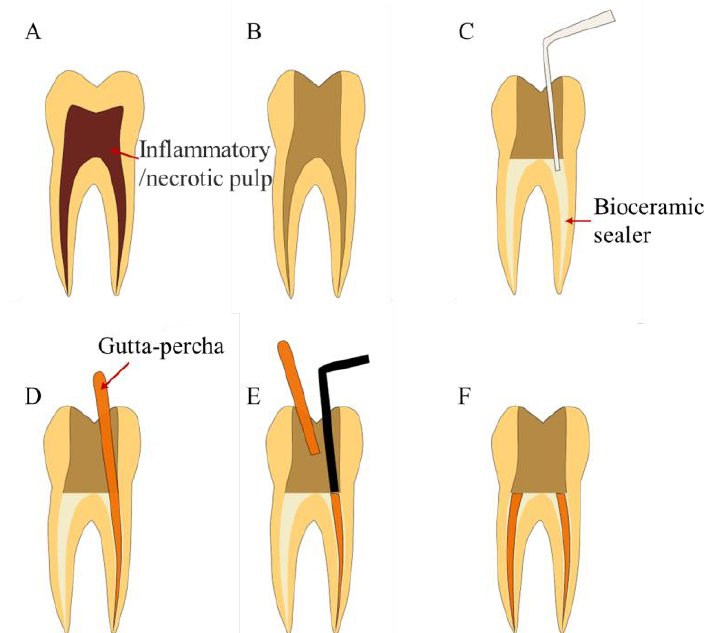
Figure 6. Treatment procedures for single-cone technique. ( A ) A tooth with pulpal or periapical disease. ( B ) Root canal cleaning and shaping. ( C ) Inject bioceramic sealer. ( D ) Insert